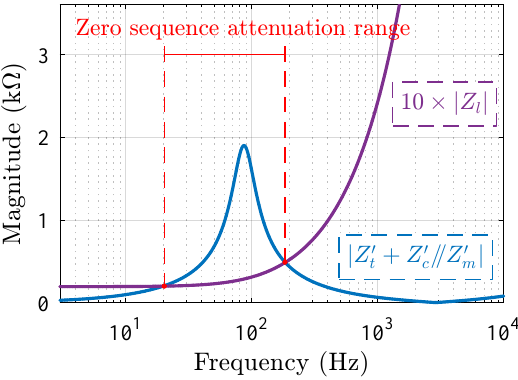
Figure 8. Evaluation of the zero sequence attenuation range for RL loads ( | Z l | = Z base and PF = 0.8). Analysis for S x closed: attenuation range between 21 Hz and 183 Hz.